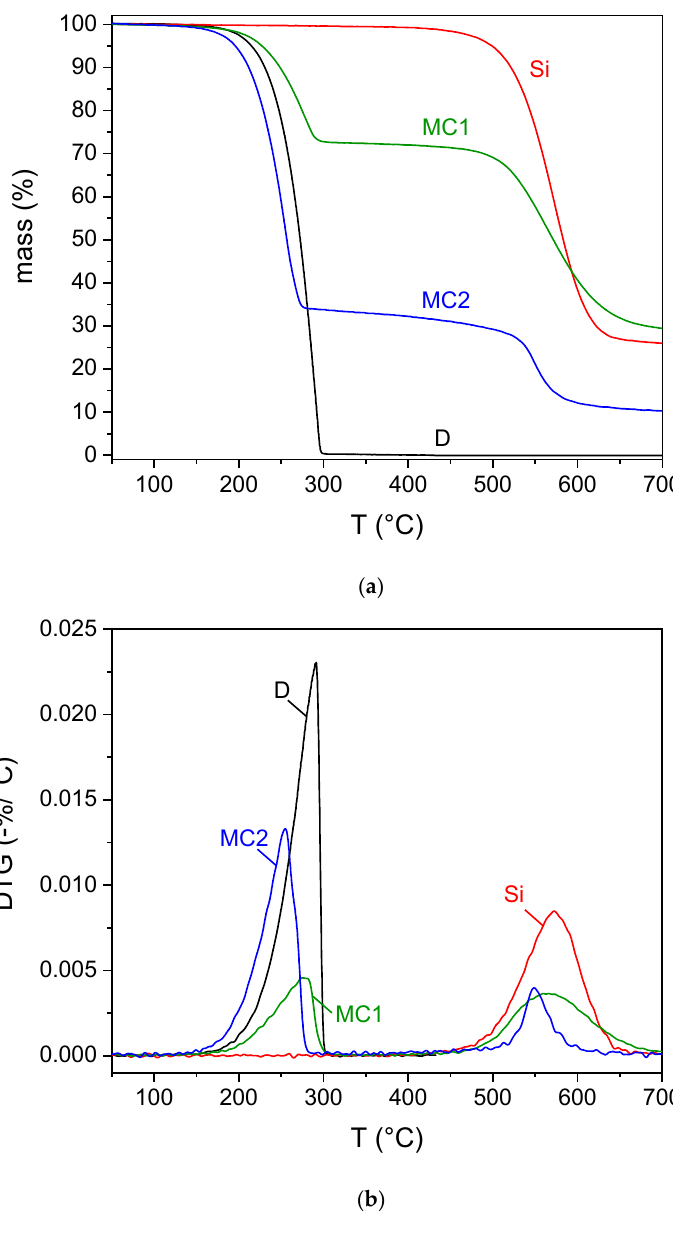
Figure 7. TGA thermograms of the bulk (D) and microencapsulated (MC1 and MC2) docosane and the neat organosilica microparticles (Si). ( a ) mass; ( b ) mass loss derivative